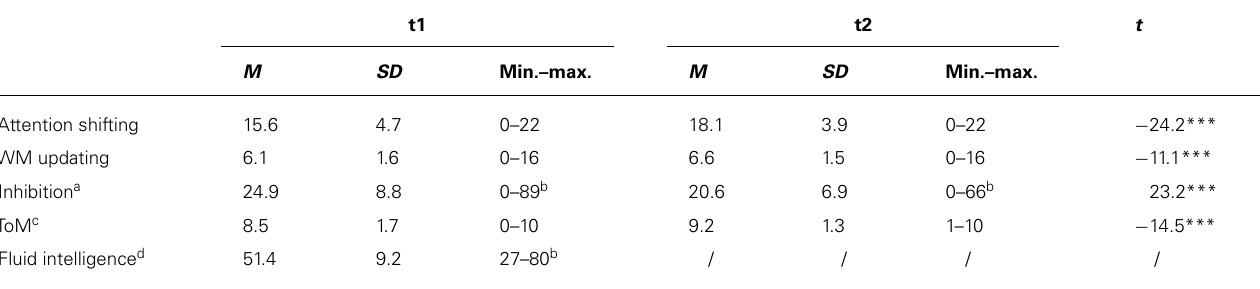
Table 1 | Descriptive statistics of assessed variables (EF subcomponents attention shifting,WM updating, inhibition, andToM cartoon task) for the two measurement time points (t1 and t2) and mean comparison results. t1 t2 t M SD Min.–max.